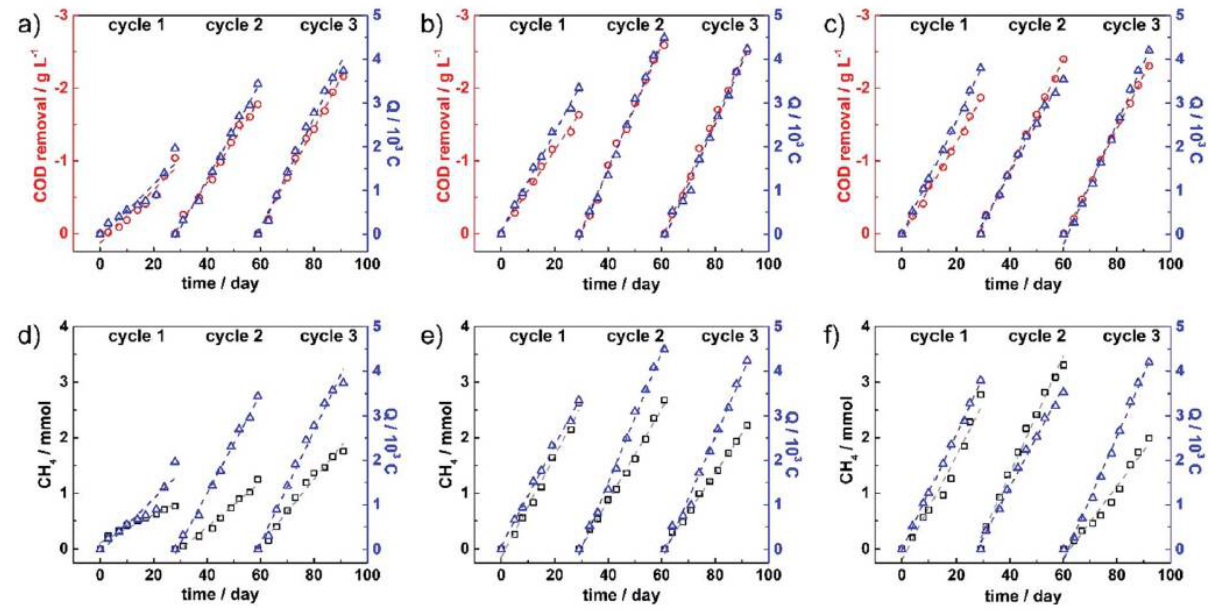
Figure 5. Plots of gathered COD removal (red circle) of ( a ) MEC 1, ( b ) MEC 2, and ( c ) MEC 3, and CH 4 production (black square) of ( d ) MEC 1, ( e ) MEC 2, and ( f ) MEC 3 over the entire running time, along with accumulated charges (blue triangles). Dashed lines represent each data set’s linear fitting curves. (Adopted from [47], open access.)